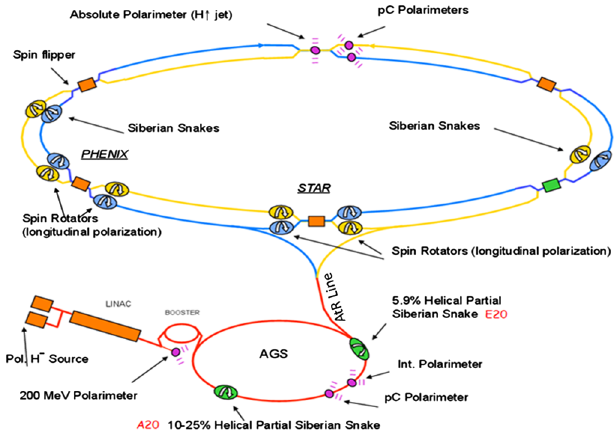
FIG. 1. The RHIC accelerator complex: The location of the AGS partial helices are shown at the A20 and E20 straight sections of the AGS. The AtR beam transfer line shown in the figure transports the beam from AGS to